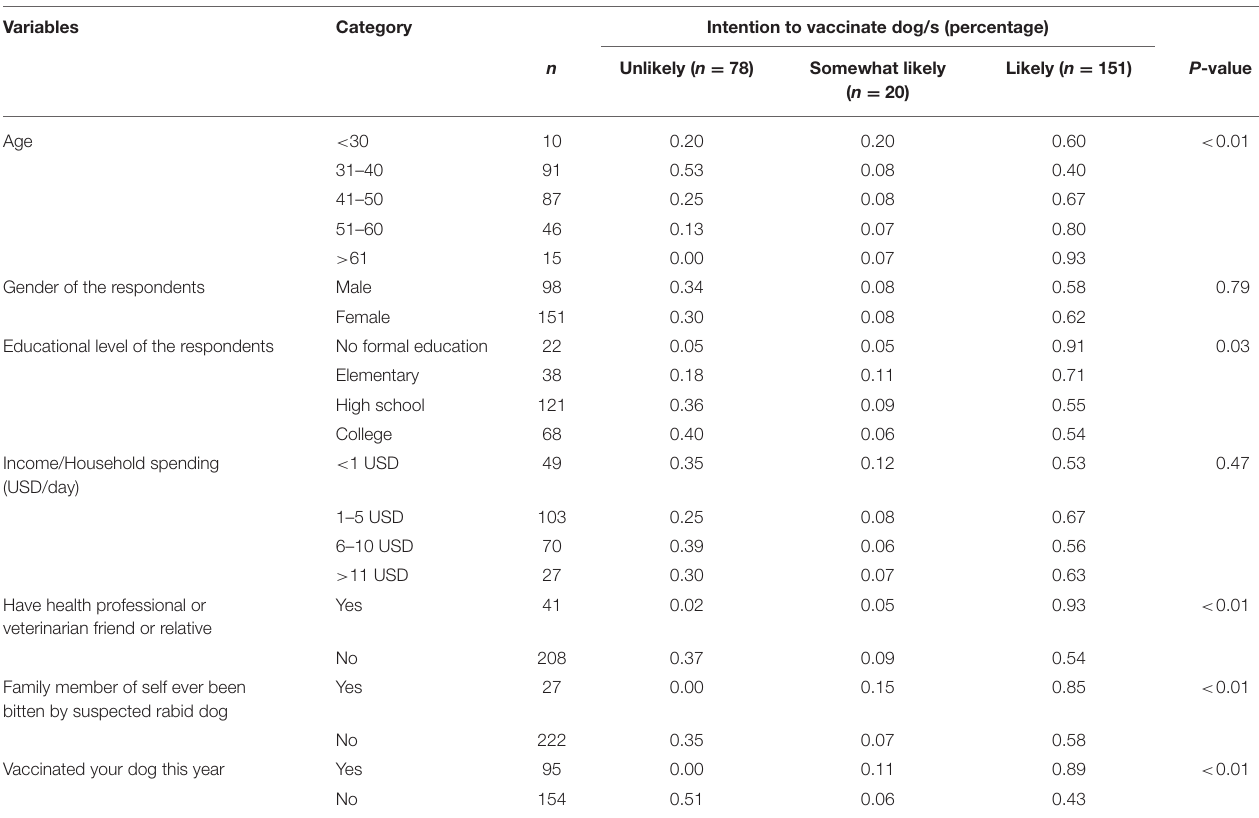
TABLE 1 | Comparison of sociodemographic, and rabies related factors across intention to vaccinate ( P -values indicate significant differences in proportions of categories of variables).